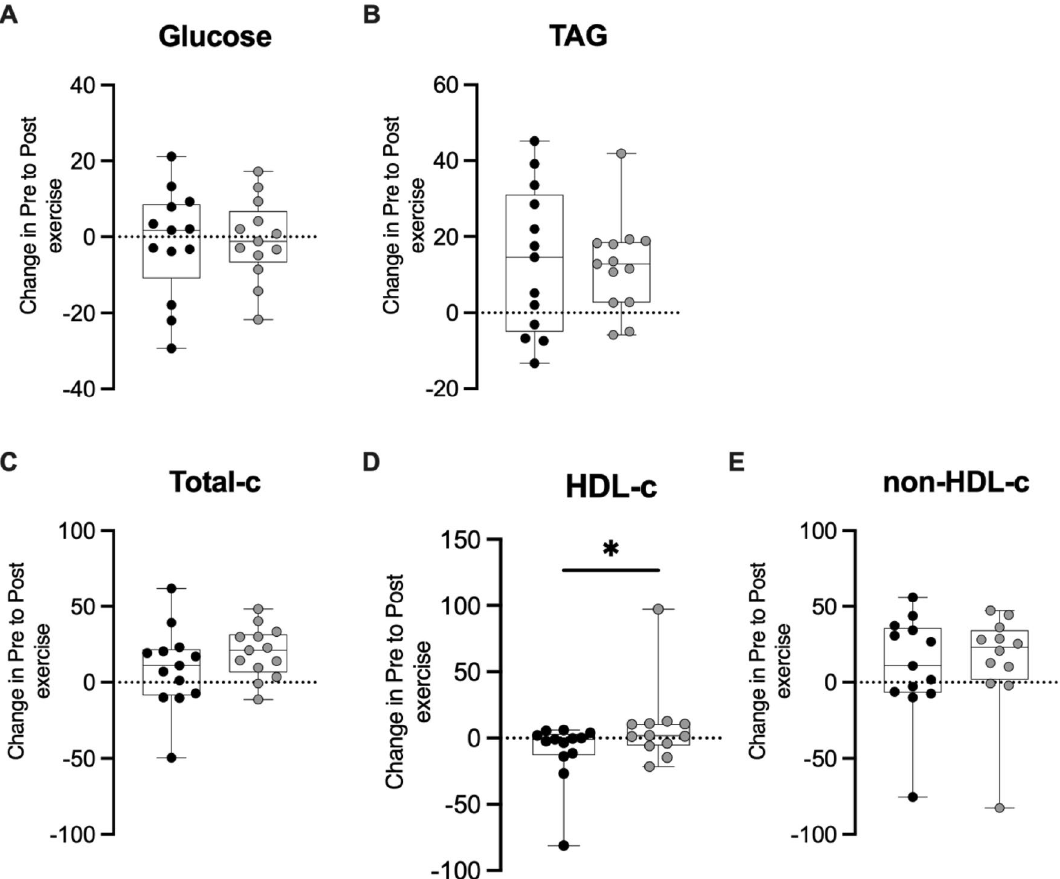
Figure 2. Delta change in metabolic parameters relative to the resting value obtained before and after badminton season. Individual data points (dots) for the total participants cohort (n = 13) ( A ) glucose, ( B ) triacylglycerol, ( C ) total cholesterol, ( D ) HDL-cholesterol, ( E ) non-HDL-cholesterol. *P-values indicate differences relative to